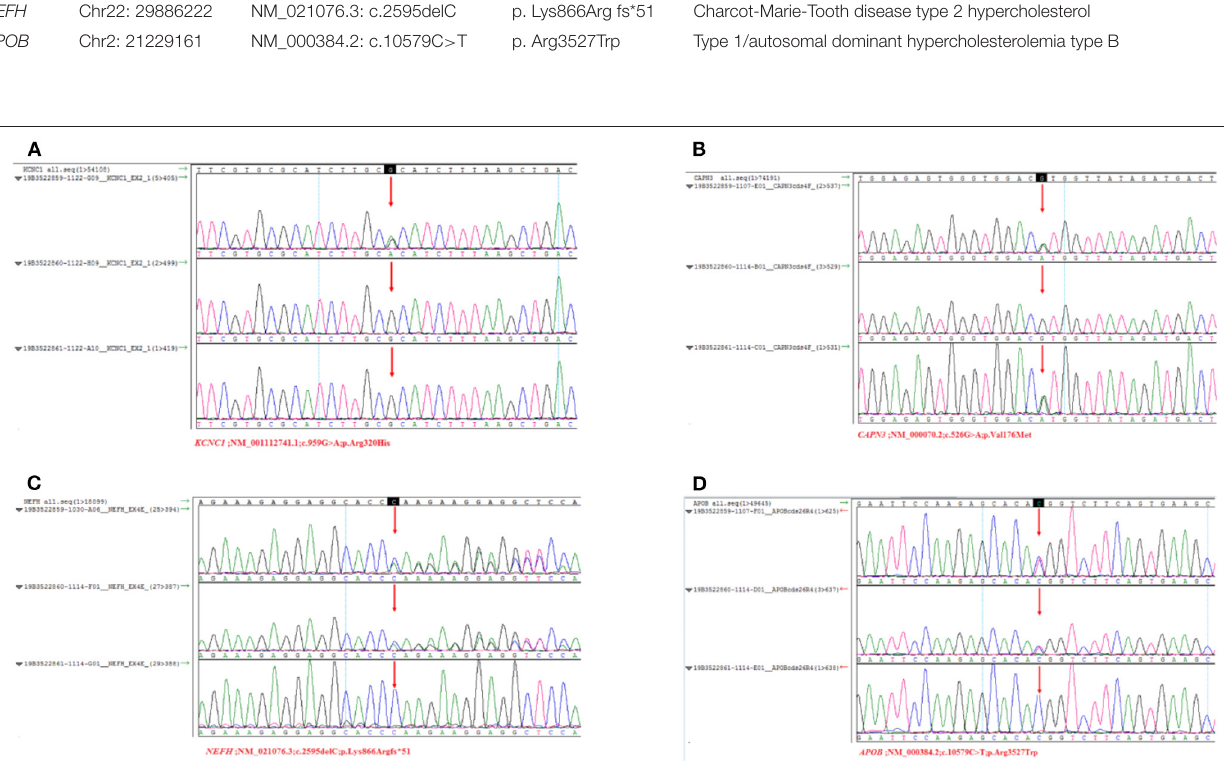
FIGURE 1 | Sanger sequencing results of the KCNC1, CANP3, NEFH, APOB. Arrows indicate the verification site of mutation. (A) The three results were sequencing results of proband, father and mother. KCNC1 was a new mutation (c. 959G > A, p. Arg320His). There was no heterozygous mutation of variant. (B) CAPN3 (c.526G > A, p. Val176Met) at this site, which was inherited from the father. (C) NEFH is a heterozygous mutation (c.259 5delC, p. Lys866Arg fs*51) inherited from the mother. (D) APOB belongs to heterozygous mutation (c.10579C > T, p. Arg3527Trp), inherited from its mother.